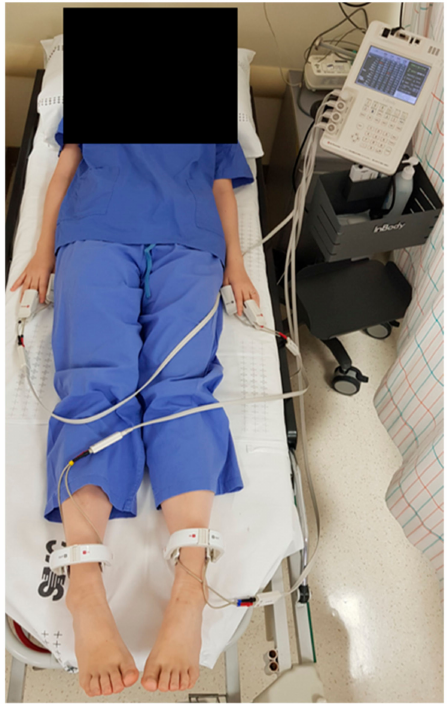
Figure 2. Whole-body bioelectrical impedance analysis